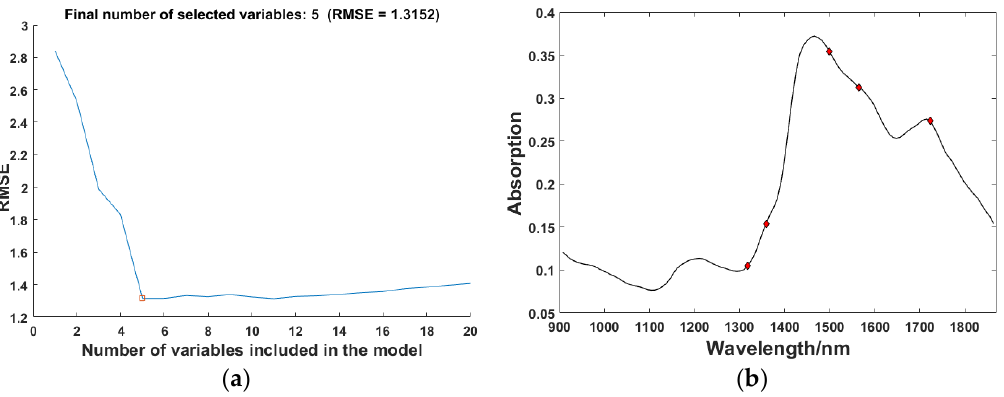
Figure 6. The results of characteristic wavelengths selection by SPA: ( a ) The variation of RMSE with SPA; ( b ) Final selected wavelengths.